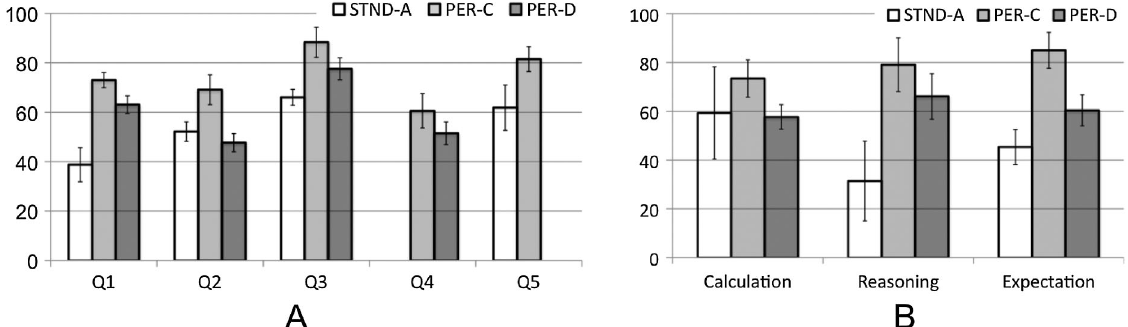
FIG. 2. Traditional exam results. (A) Traditional exam questions: Average percent score on five traditional exam questions across three semesters. Error bars represent 1 standard error of the mean. (B) Traditional exam strategies: Portions of questions grouped by problem-solving strategy: calculation and correctness (i.e., Q1 correctness; Q2 calculation of bound charge V and limiting behavior; Q3 calculation of V ), reasoning (Q2 explanations, Q3 reasoning), and expectation of limiting behavior (Q2 articulation of limiting behavior). SE for categories in (B) is obtained by adding the SEs for the individual questions in that category, in